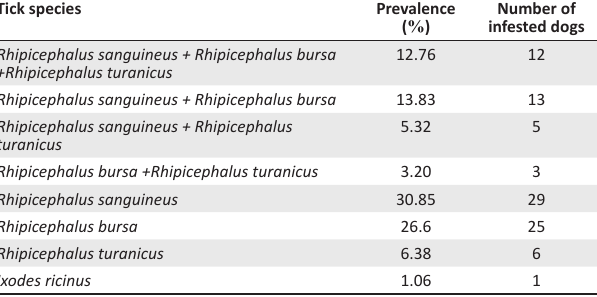
TABLE 3: Prevalence of infested dogs in the Bejaia province, northeastern Algeria, with mixed tick infestations. Tick species